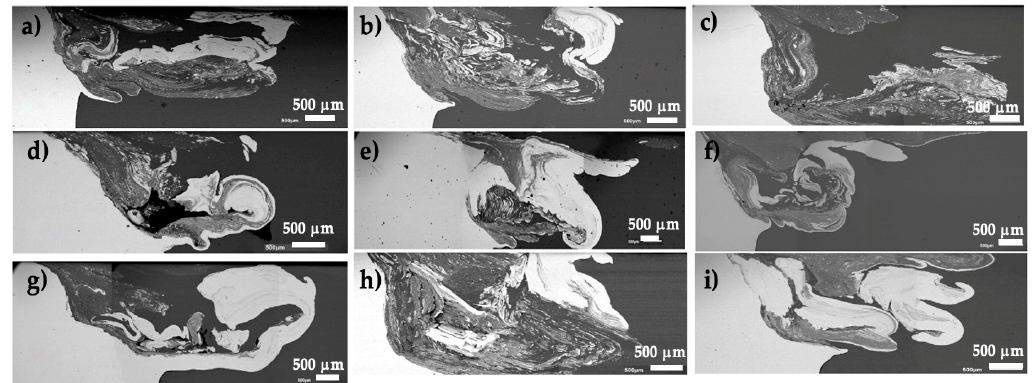
Figure 8. SEM microstructures of weld zones for all the Al-Cu FSW samples. ( a ) 1000_20, ( b ) 1000_40, ( c ) 1000_60, ( d ) 1150_20, ( e ) 1150_40, ( f ) 1150_60, ( g ) 1300_20, ( h ) 1300_40, ( i )